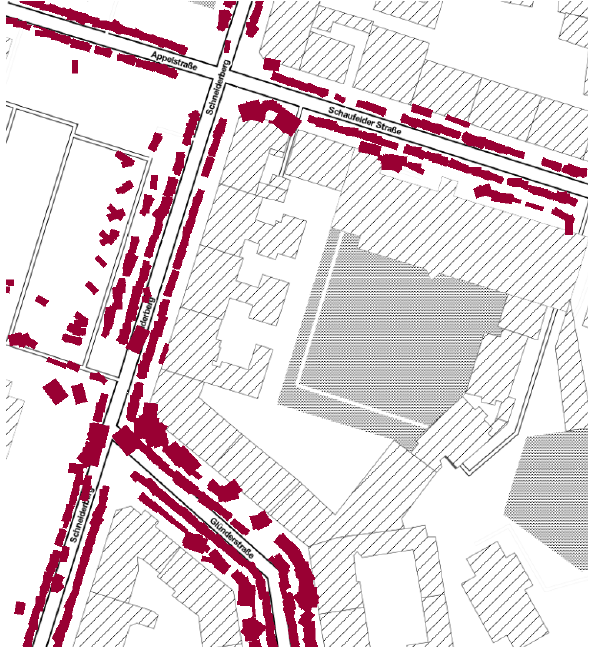
Figure 11. The extracted cars (red boxes) on top of a basemap (Stamen maps).